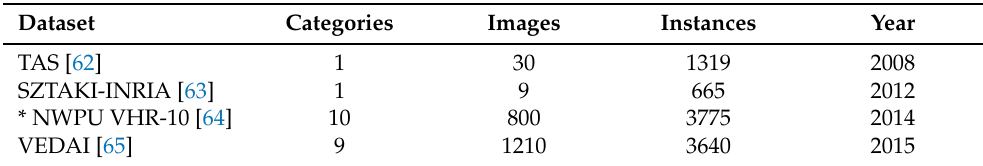
Table 1. Existing public optical remote-sensing datasets. * denotes that corresponding dataset contains ship